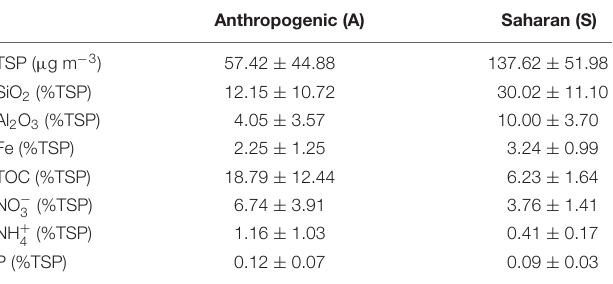
TABLE 2 | Chemical composition of the A ( N = 16) and S ( N = 6) filters used through the six experiments, as average and standard